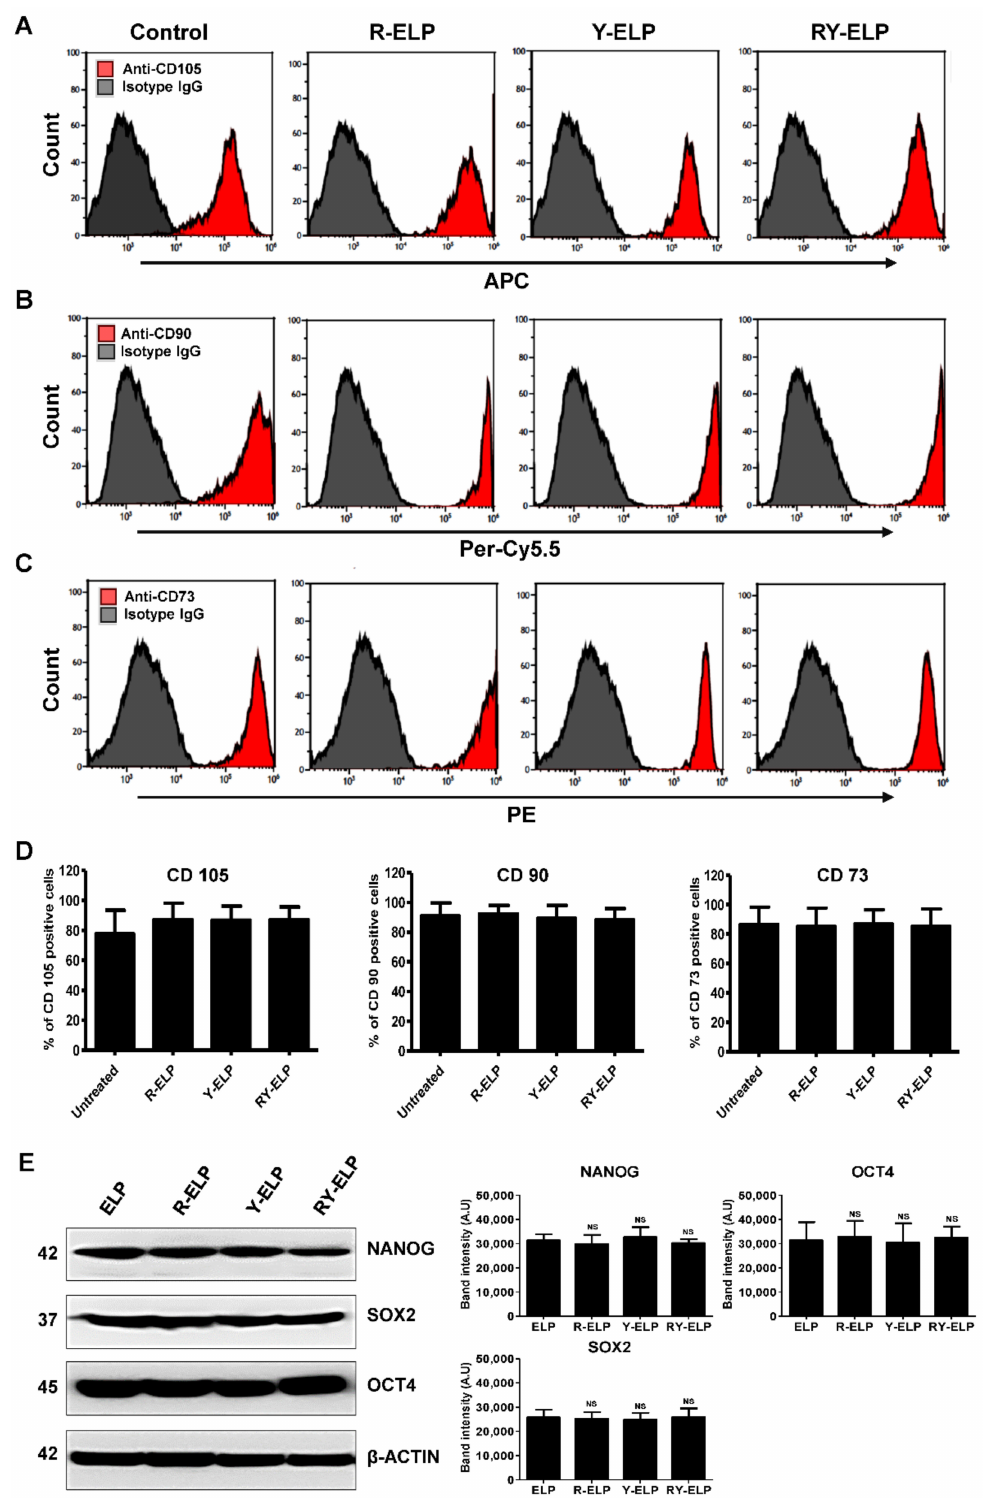
Figure 8. Evaluation of stemness properties of MSCs on ELP matrix. ( A – C ) Human bone-marrow- derived MSCs were analyzed for three positive mesenchymal stem cell markers CD73, CD90, and CD105 by flow cytometry. ( D ) The level of expression of mesenchymal stem cell markers observed in comparison with noncoated groups. The graph represents the mean ± SD ( n = 3). ( E ) Western blot showing the endogenous protein expression of Nanog, SOX2, and OCT4 of MSCs cultured in coated plates and data were expressed as mean ± SD ( n = 3), NS—not